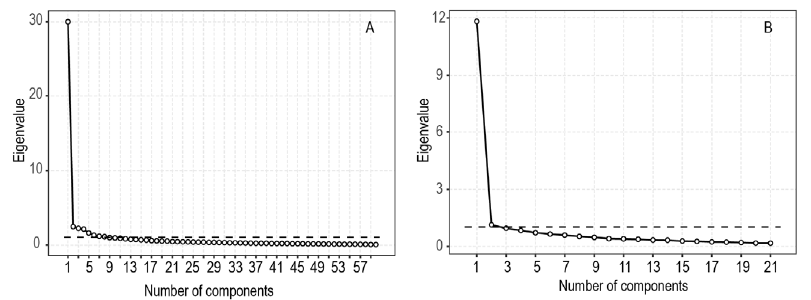
Figure 1. The scree plots from both phases of the development of MisoQuest: ( A ) the first phase, in which 60 items were used; ( B ) the second phase, in which 21 items were used.